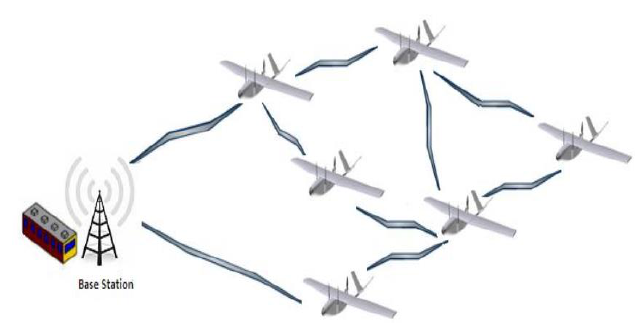
Figure 3. Architecture of Flying ad-hoc network